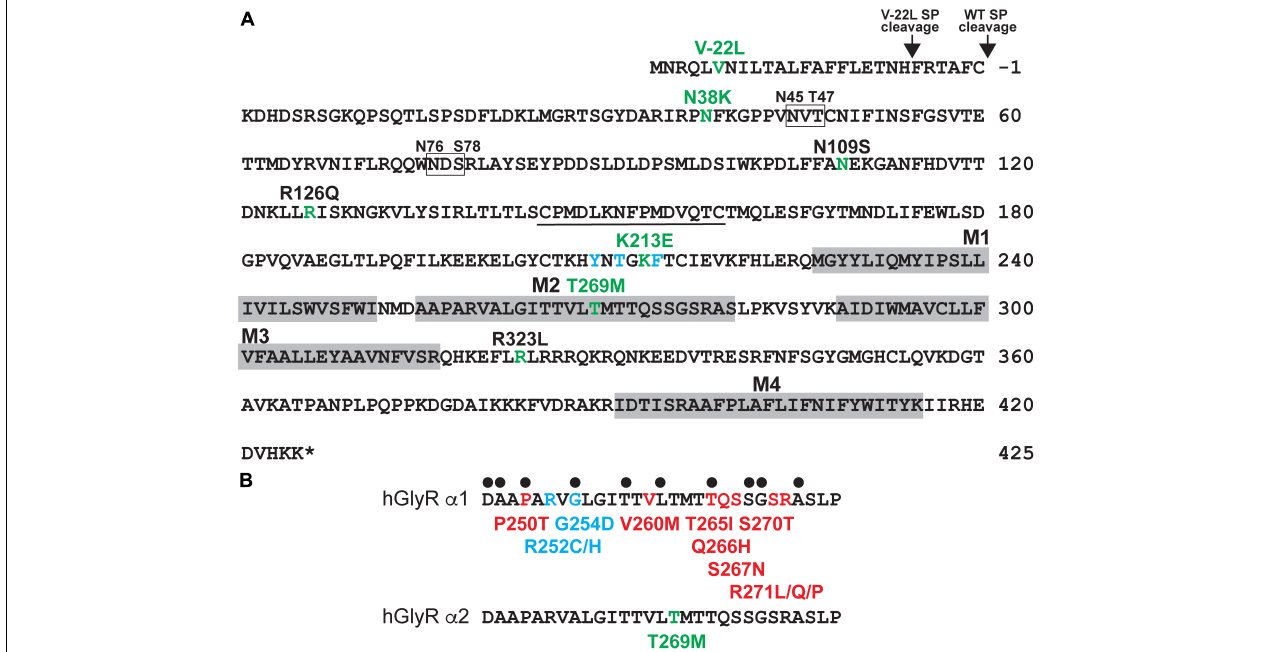
Frontiers in Molecular Neuroscience |